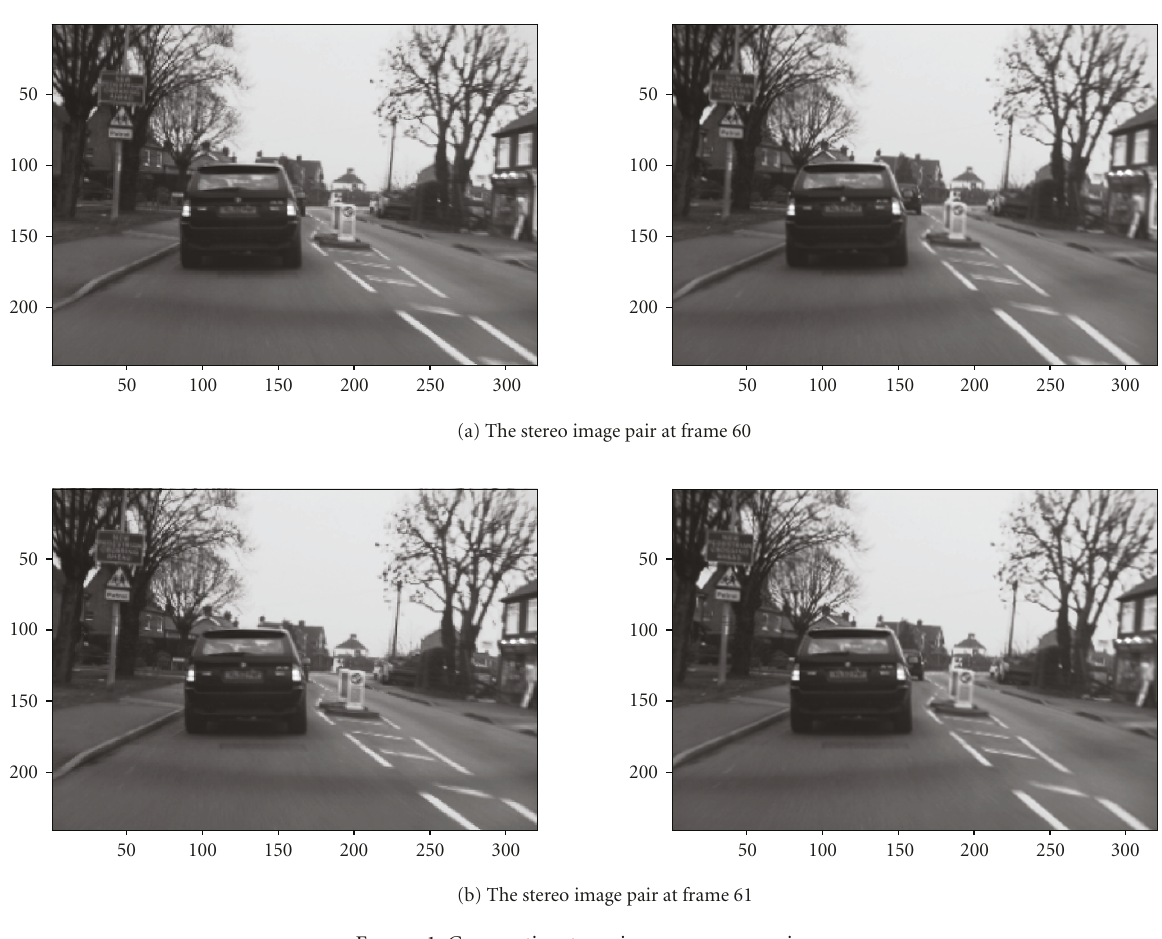
Figure 1: Consecutive stereo image sequence